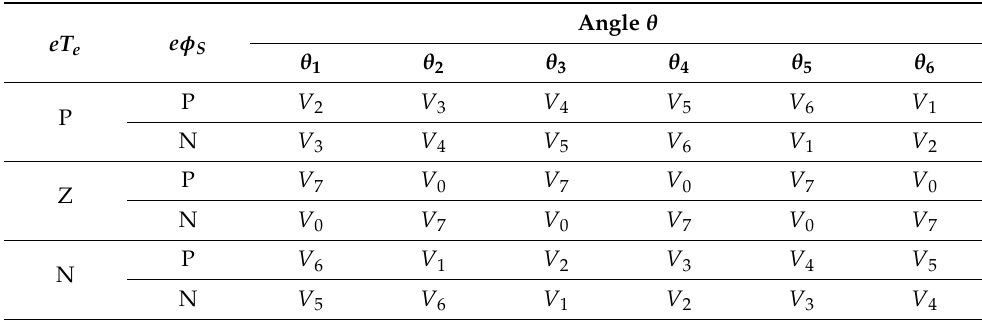
Table 5. Fuzzy switching logic rule of FDTC.